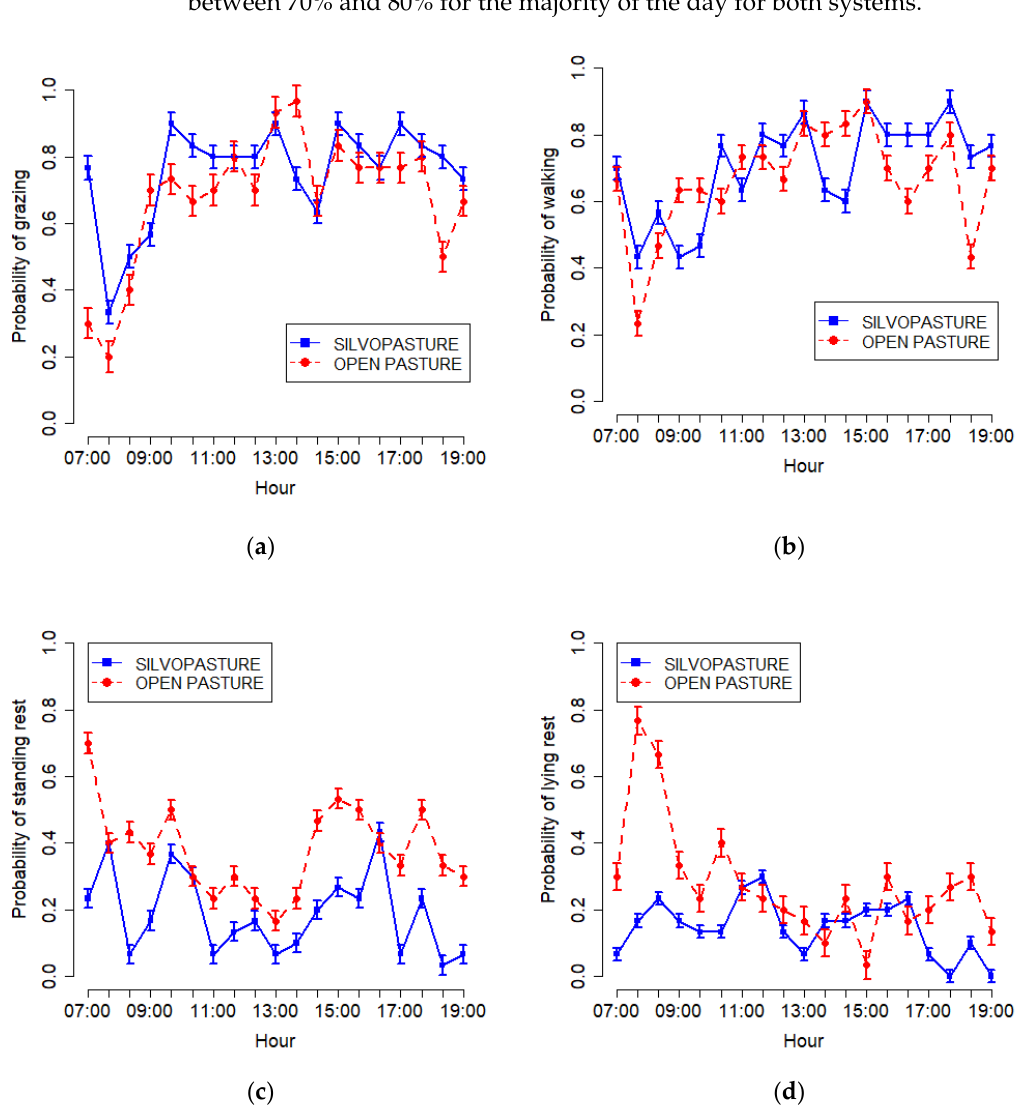
Figure 1. Probability of grazing ( a ), walking ( b ), standing at rest ( c ) and lying at rest ( d ) of lambs in the silvopastoral system (continuous line in blue) and open pasture (dashed line in red) throughout the periods of the day. Lambs in the SP grazed longer at more critical temperatures than those exposed to the full sun. Although animals in the extensive system performed grazing activity more than half of the time and at different times of the day [47], lambs needs to have a thermal